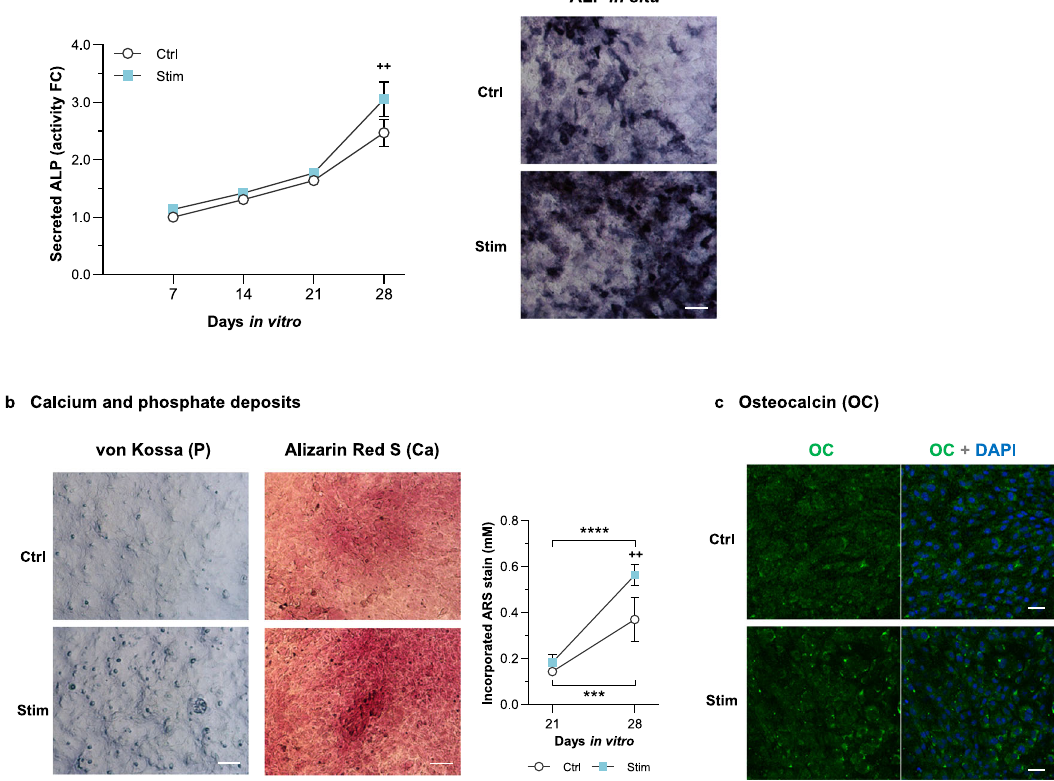
Fig. 3 High frequency stimuli effects on ALP activity and mineralization of MC3T3 osteoblasts. a Activity pro fi le of alkaline phosphatase (ALP) secreted to the cells' conditioned medium under Ctrl and Stim conditions over time (left graph, n = 3 – 4); right: in situ detection of ALP on cells cultured for 28 DIV under Ctrl and Stim conditions; scale bar, 100 μ m. b Detection of calcium and phosphate deposits upon 28 DIV under Ctrl and Stim conditions by von Kossa staining of phosphate nodules and Alizarin Red S (ARS) staining of calcium-rich deposits; scale bars, 100 μ m. Incorporated ARS stain was quanti fi ed at 21 and 28 DIV under Ctrl or Stim conditions ( n = 3 – 4). c Immunostaining of osteocalcin (OC, in green) distributed in the cellular matrix upon 28 DIV under Ctrl or Stim conditions. Cells ’ nuclei were counterstained with DAPI (blue); scale bar, 50 μ m. Results are presented as mean ± SD. Statistic symbols: ( + ) Ctrl vs Stim conditions; (*) between timepoints within the same condition; ++ P < 0.01, *** P < 0.001, **** P <